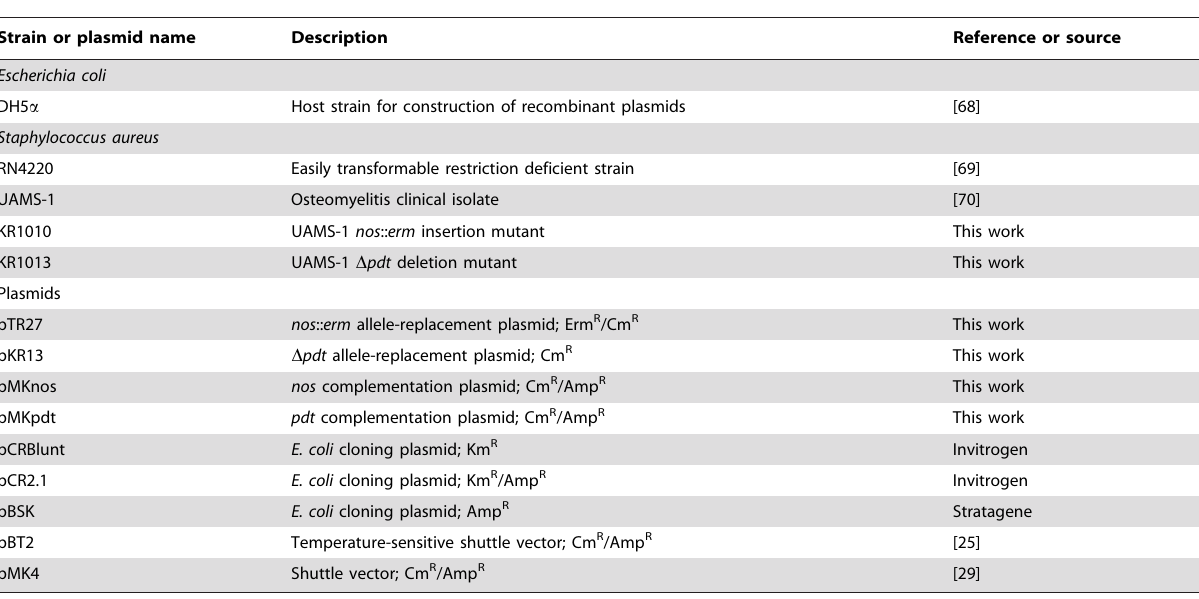
Table 1. Bacterial strains and plasmid constructs used in this study.